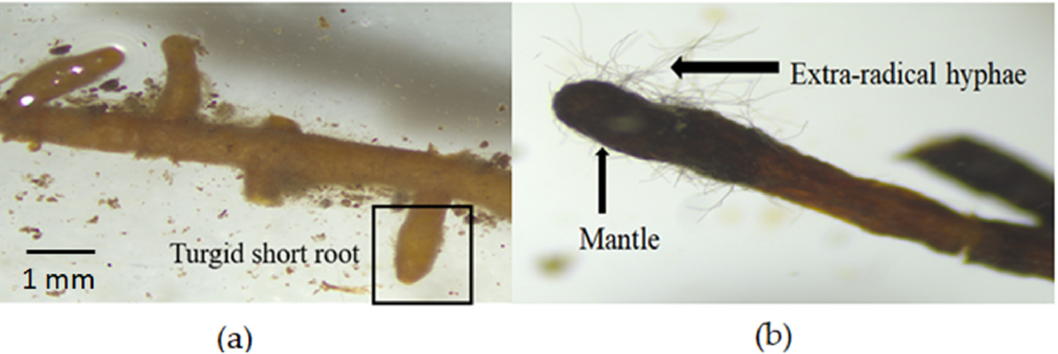
Figure 5. Two typical ectomycorrhizal structures of the fine roots of Abies beshanzuensis . ( a ) Short mycorrhizal lateral roots, which is called heterorhizy, supported by a network of thicker, long roots for resisting pathogen stresses. ( b ) Fungal hyphae enter the cortex to form a Hartig network, while forming a firm